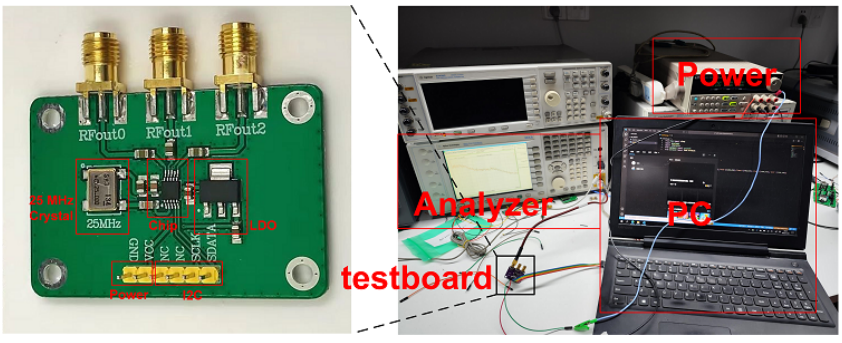
Figure 13. Testbench of proposed FNPLL.